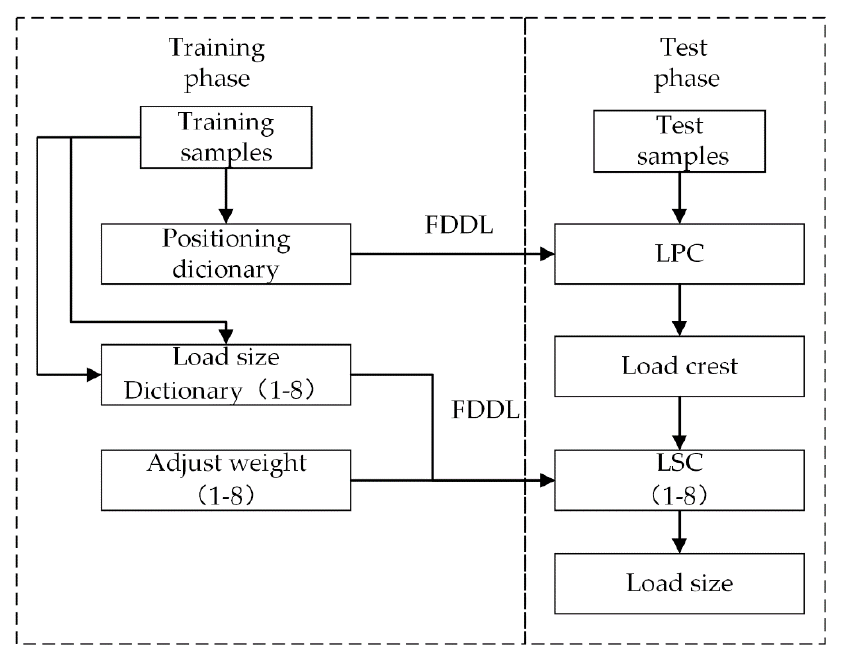
Figure 6. Algorithm flow of load